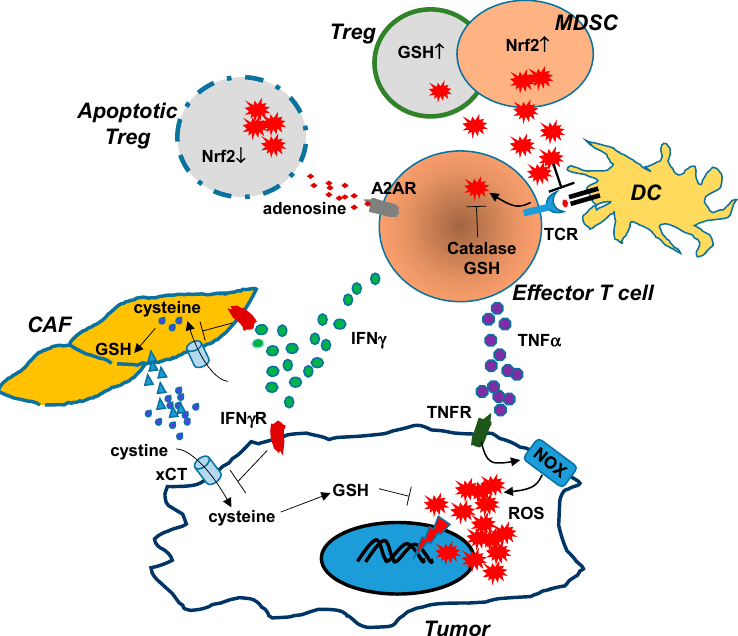
Figure 1. Interactions between cells in the TME lead to changes in redox status. Tumor-reactive effector T cells (CD4+ and CD8+) can induce increased levels of ROS in cancer cells via the actions of IFN γ and TNF α . TNF α signaling in tumor cells activates NADPH oxidases, which lead to increased production of ROS. IFN γ signaling in tumor cells diminishes xCT expression through transcriptional inhibition, reducing tumor uptake of extracellular cystine and subsequent GSH synthesis. IFN γ signaling in cancer-associated fibroblasts (CAF) blocks the release of GSH and cysteine, further depleting the extracellular pool of cystine and cysteine available to cancer cells. The severe redox imbalance in cancer cells, caused by TNF α -driven ROS production and IFN γ -induced GSH deficiency, leads to extensive oxidative damages and eventual tumor cell death. However, effector T cells are also susceptible to oxidative stress in the TME. ROS induced upon TCR engagement are counterbalanced by increased antioxidant systems such as GSH and catalase. T cell dysfunction may occur when effector T cells are exposed to ROS produced by MDSCs and Tregs, which are more resistant to oxidative stress due to their increased antioxidant systems. High levels of extracellular ROS can disrupt antigen-presentation between T cells and DCs, and can affect tumor antigen recognition by T cells. Some apoptosis-prone Tregs can increase the presence of adenosine in the TME, which suppresses the function of effector T cells in an A2AR-dependent manner. Therapeutic interventions should be directed to enhance T cell-induced tumor oxidative stress while enabling T cells to resist the elevated oxidative stress in the TME.